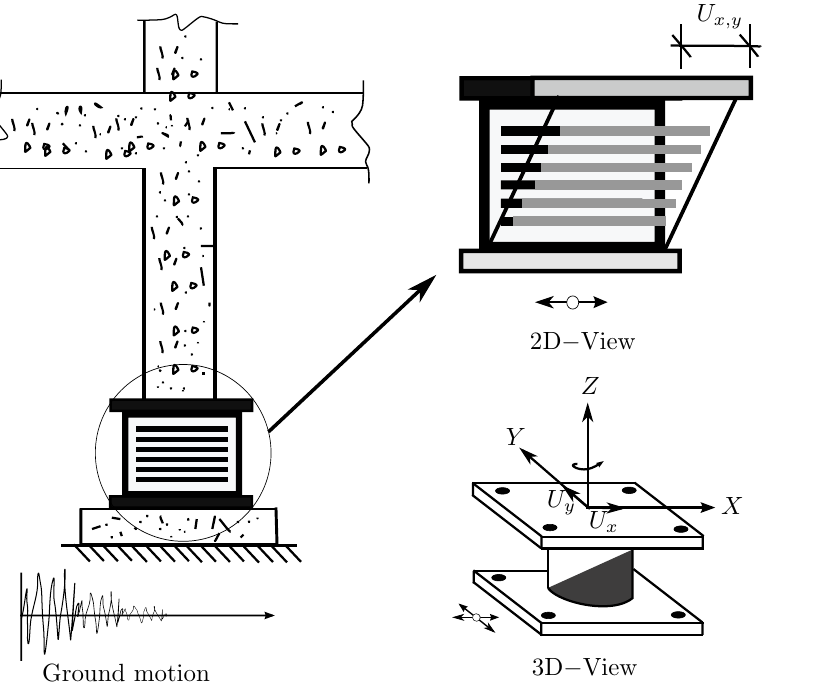
Figure 2. A bearing under column excited by an earthquake ground